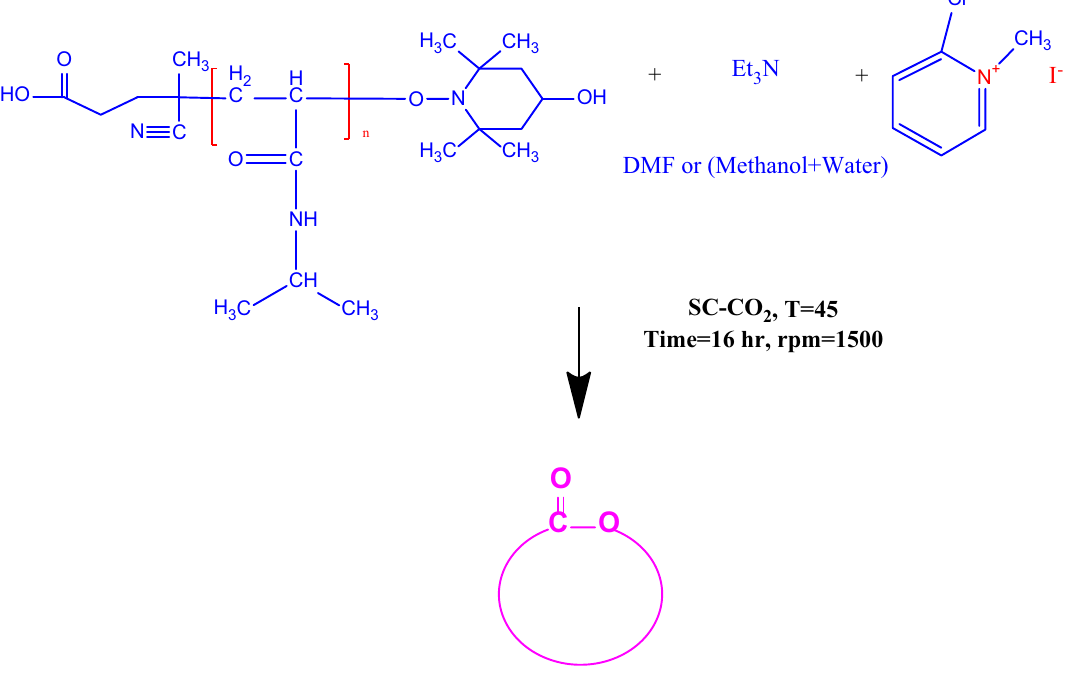
Figure 5. Synthesis of cPNIPAAM in SC-CO 2 by using lactonization reaction.